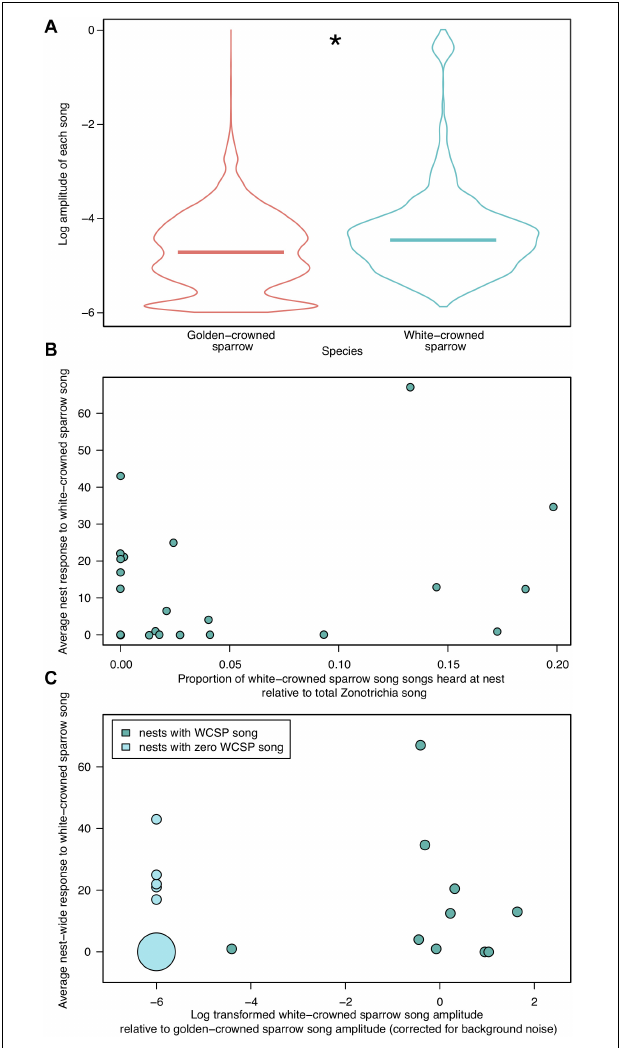
FIGURE 3 | (A) The amplitudes of all recorded Zonotrichia songs at each golden-crowned sparrow nest ( N = 20), log-transformed to aid visualization. White-crowned sparrow songs (right), although less frequently heard, were on average louder than golden-crowned sparrow songs (left) heard at golden-crowned sparrow nests (medians shown with horizontal bars; Wilcoxon rank-sum test, P < 0.001). (B) Average response of golden-crowned sparrow nestlings to white-crowned sparrow playback, as explained by proportion of white-crowned sparrow song to total Zonotrichia song heard at the nest during the dawn chorus. There was no effect of proportion of white-crowned sparrow song on average responsiveness (linear model; P = 0.252, N = 23). For results of the full generalized linear model, see Section “Results” and Table 1 . (C) Average response of golden-crowned sparrow nestlings to white-crowned sparrow song playback, as explained by relative amplitude of white-crowned sparrow songs at each nest. Ratios of average white-crowned sparrow amplitude to average golden-crowned sparrow amplitude are transformed to a log scale to aid visualization; larger negative values represent nests with higher ratios of golden-crowned sparrow amplitude relative to white-crowned sparrow amplitude, and vice versa . Nests with no white-crowned sparrow songs (zero amplitude) are represented in lighter blue and assigned to an arbitrary value of -7 on this scale. The area of each circle represents the number of points at identical coordinates. The amplitude of white-crowned song did not predict the response to white-crowned song (linear model P = 0.65, N =